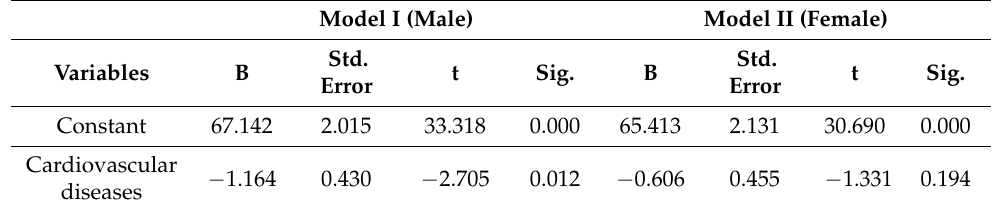
Table 2. Regression analysis